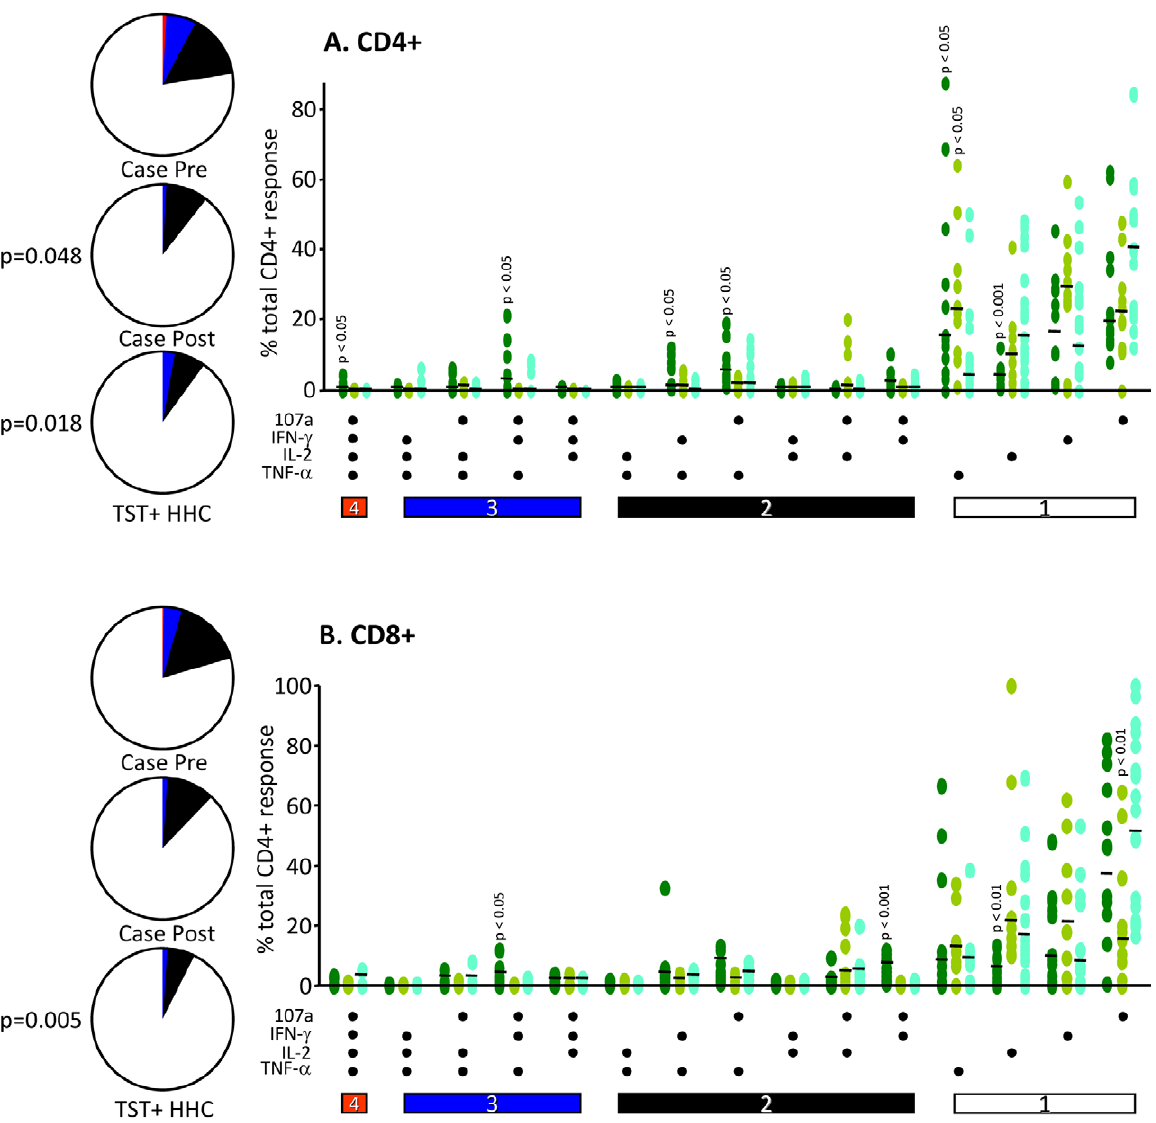
Figure 3. The functional profile of CD4 + and CD8 + T cells is increased in TB cases but reduced post-treatment. PBMC were stimulated overnight using ESAT-6/CFP-10 and CD4 + and CD8 + cells were analysed by flow cytometry for different combinations of IFN- c , IL-2, TNF- a and CD107a. Responses are grouped and colour coded according to the number of factors: White =1 function, black = any 2 factors, blue = any 3 factors and red = all 4 factors. The pie charts summarise the results shown in the dot plots indicating the combination of cytokines as a percent of total responding cells for CD4 + (A) and CD8 + (B). Significant differences are indicated and were determined using a Kruskal-Wallis ANOVA followed by Dunn’s post-test comparison. Pie chart segments were analysed using a permutation test and p-values